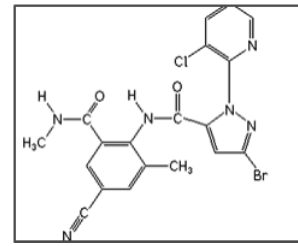
Figure 1: Structure diagram of